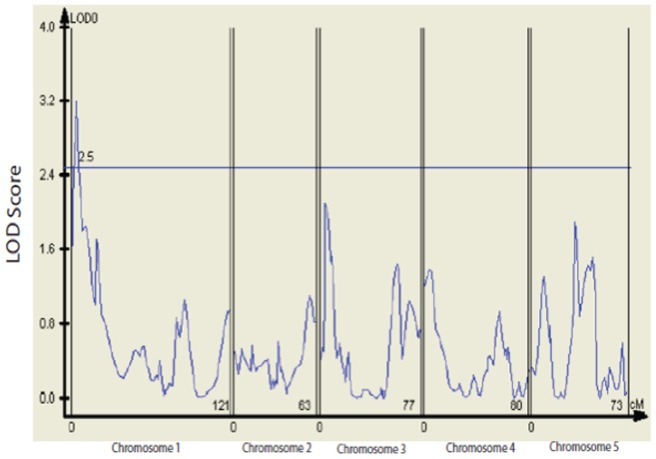
The LOD score as a function of map location.The horizontal line at 2.5 is the significance threshold.